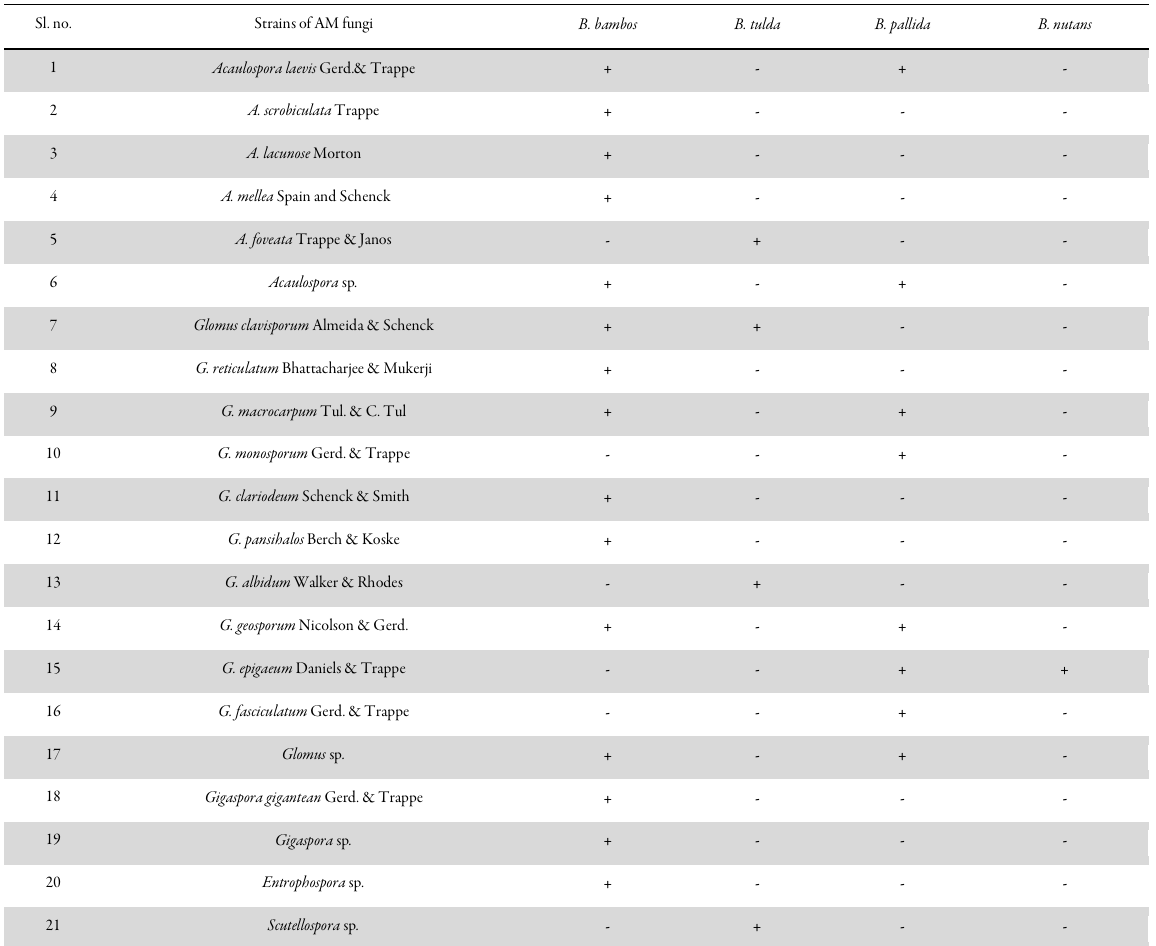
Table 3. Occurrence of AM fungi among the bamboo species Sl.